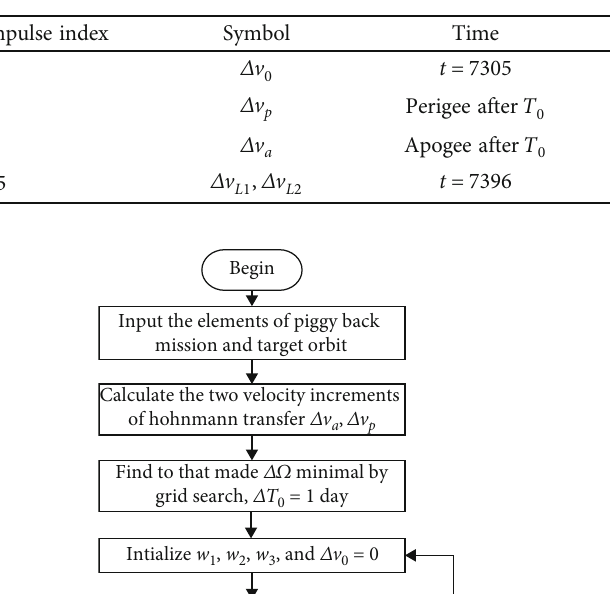
Table 7: Velocity increments of the fi ve-impulse transfer.